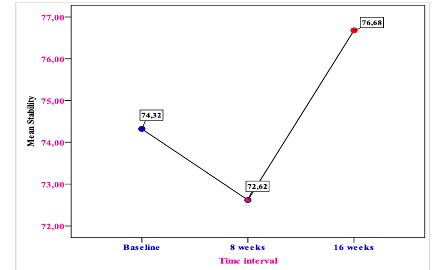
Figure 9: Line diagram showing the changes of mean ISQ (implant stability) at the time of surgery and after 2 successive intervals.